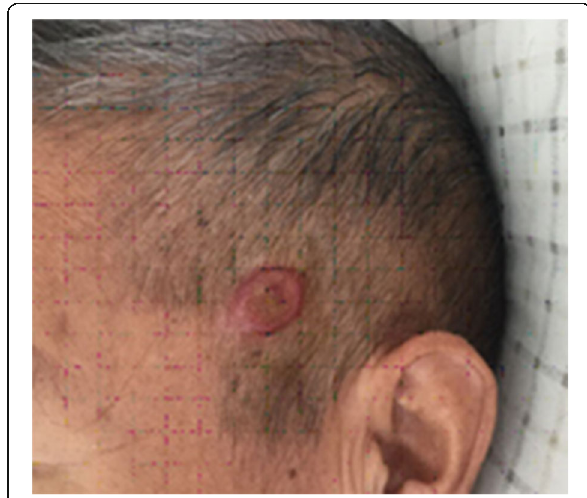
Fig. 5 Cyst adenoma occurred on the head skin of the patient in case 1. This finding added phenotypic expression data